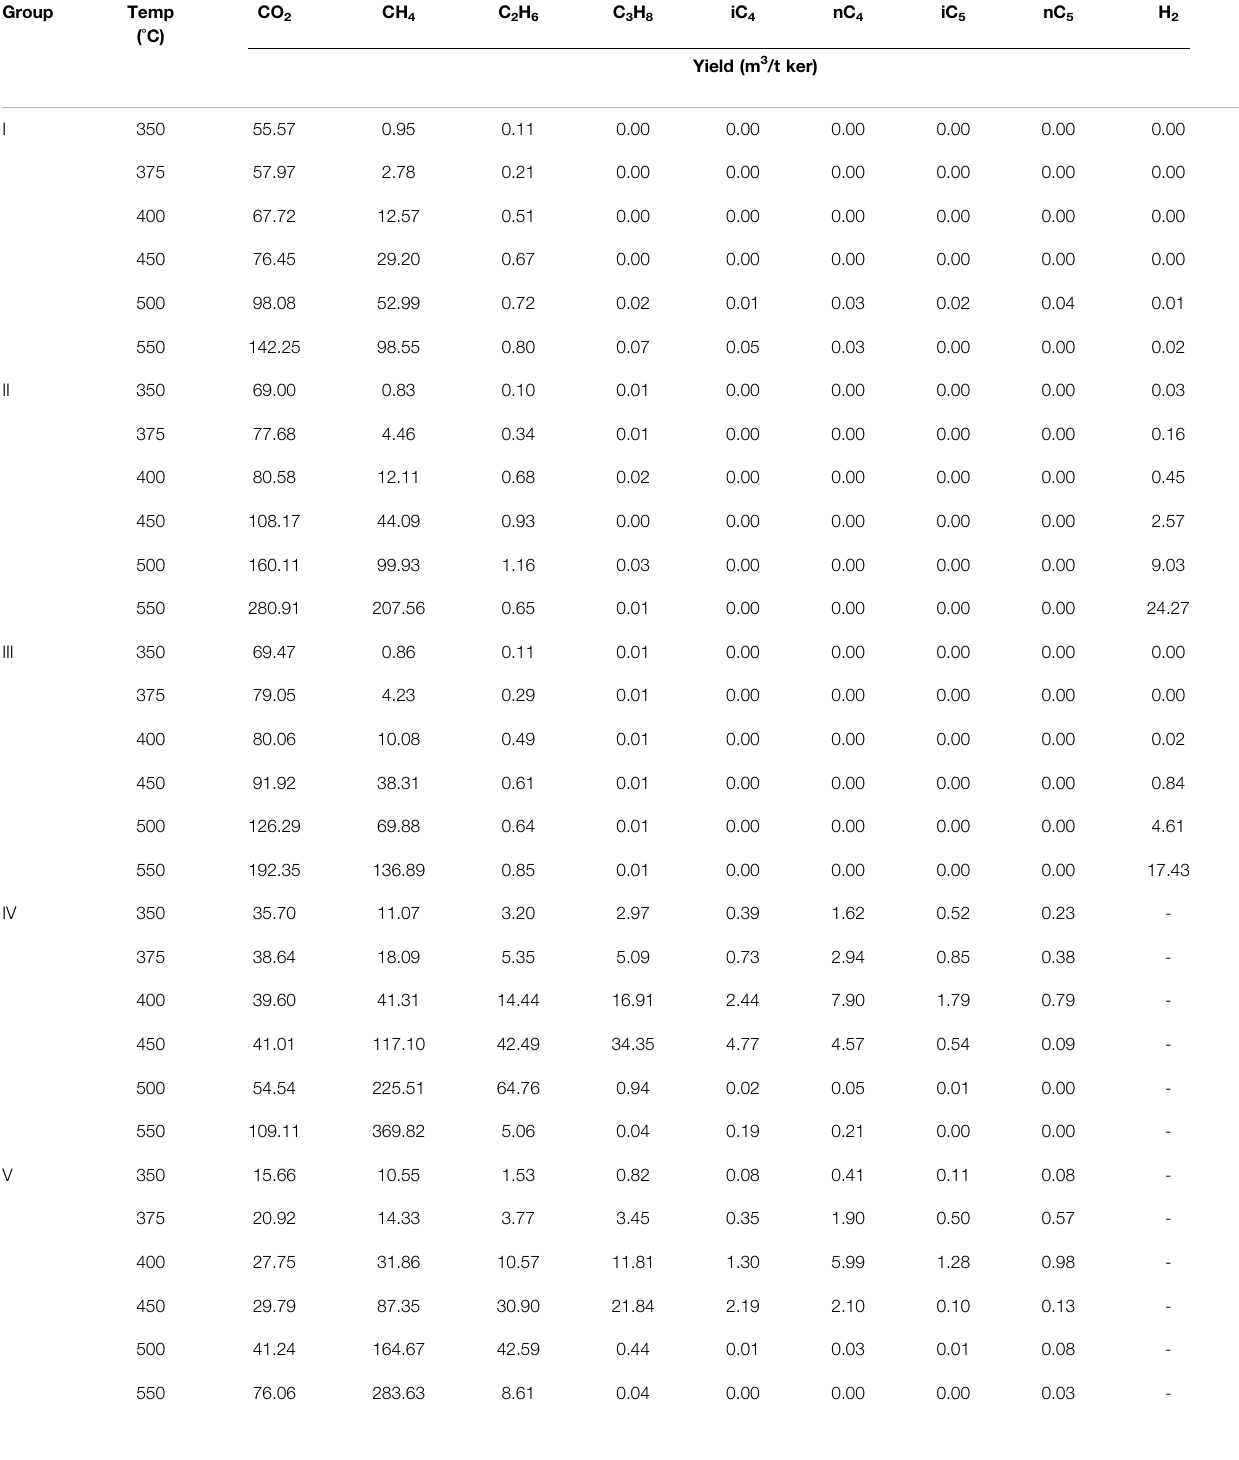
TABLE 1 | Types and concentrations (m 3 /t Ker) of gas generated during the catalytic pyrolysis experiments at 350 ° C/72 h, 375 ° C/72 h, 400 ° C/72 h, 450 ° C/72 h, 500 ° C/ 72 h, and 550 ° C/72 h. Group Temp ( °